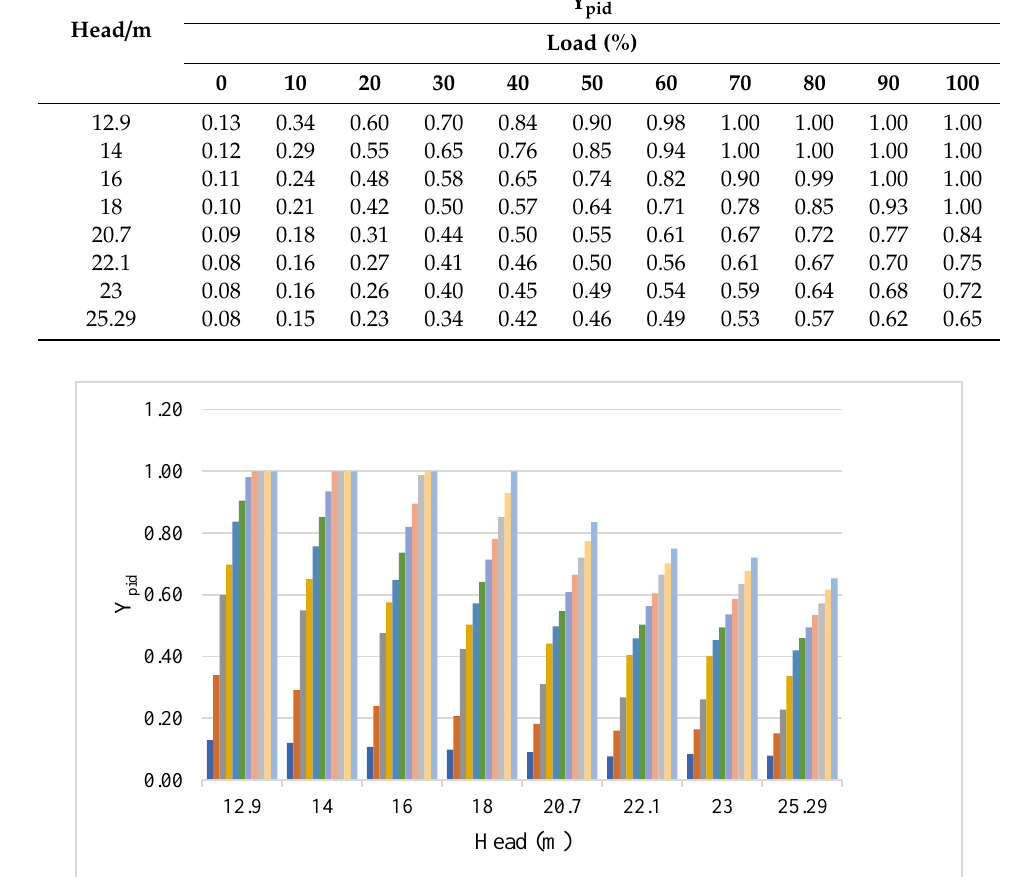
Table A1. Steady Y pid values of feed-forward control calculating at different water heads and loads. Head/m